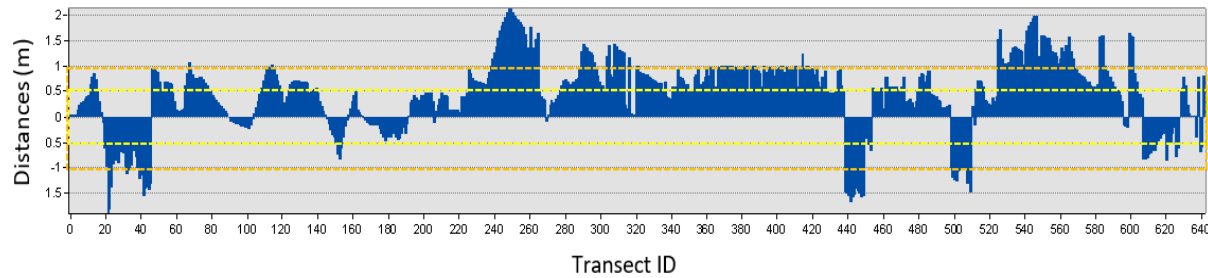
Figure 6 . Distances between extracted and digitized